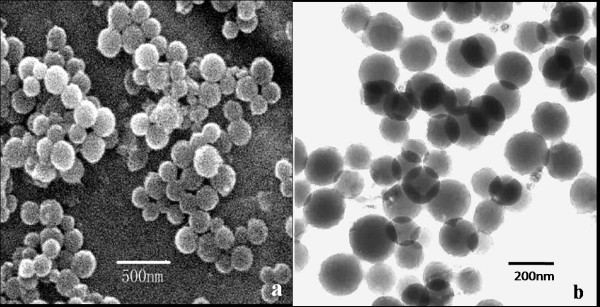
The morphologies and microstructures of HMSNs. The HMSNs dispersed in phosphate buffer solution and observed by SEM (a) and TEM (b).